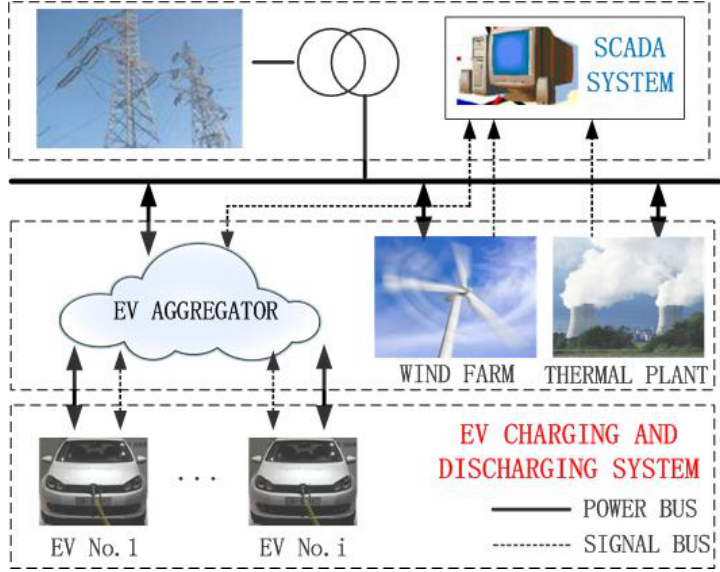
Figure 1. Conceptual system framework. EV: electric vehicle. SCADA: supervisory control and data acquisition